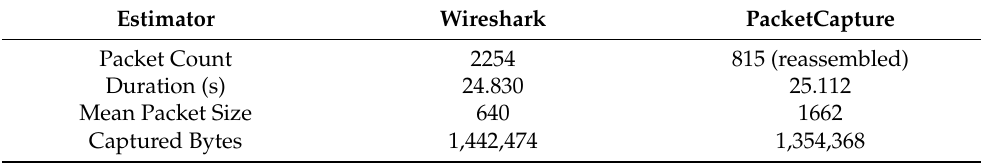
Table 4. Quantitative comparison of Packet Capture to Wireshark.